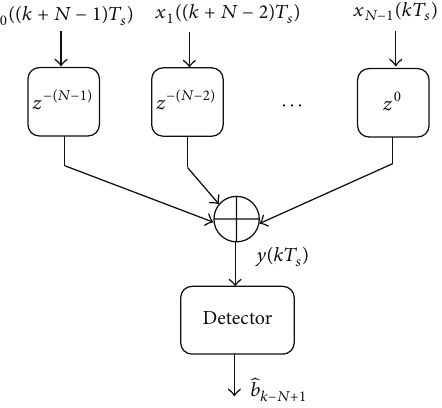
Figure 6: The delayed symbols combiner of the outputs of RAKE